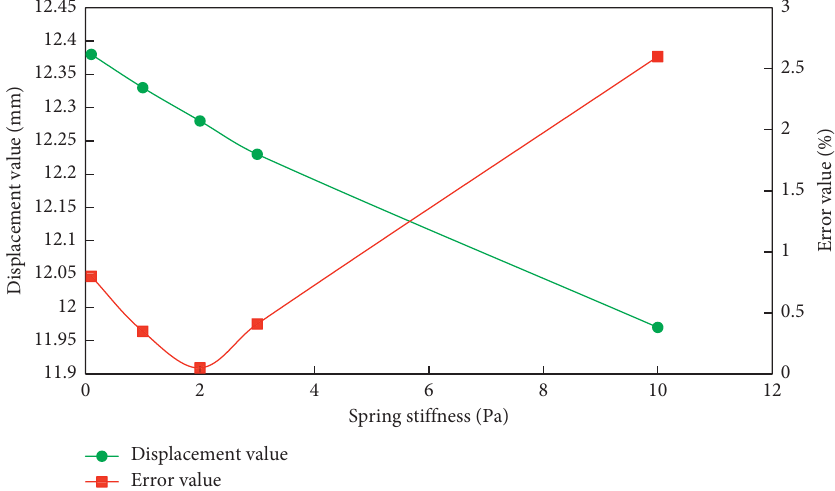
Figure 5: Comparative analysis of spring displacement and error with different